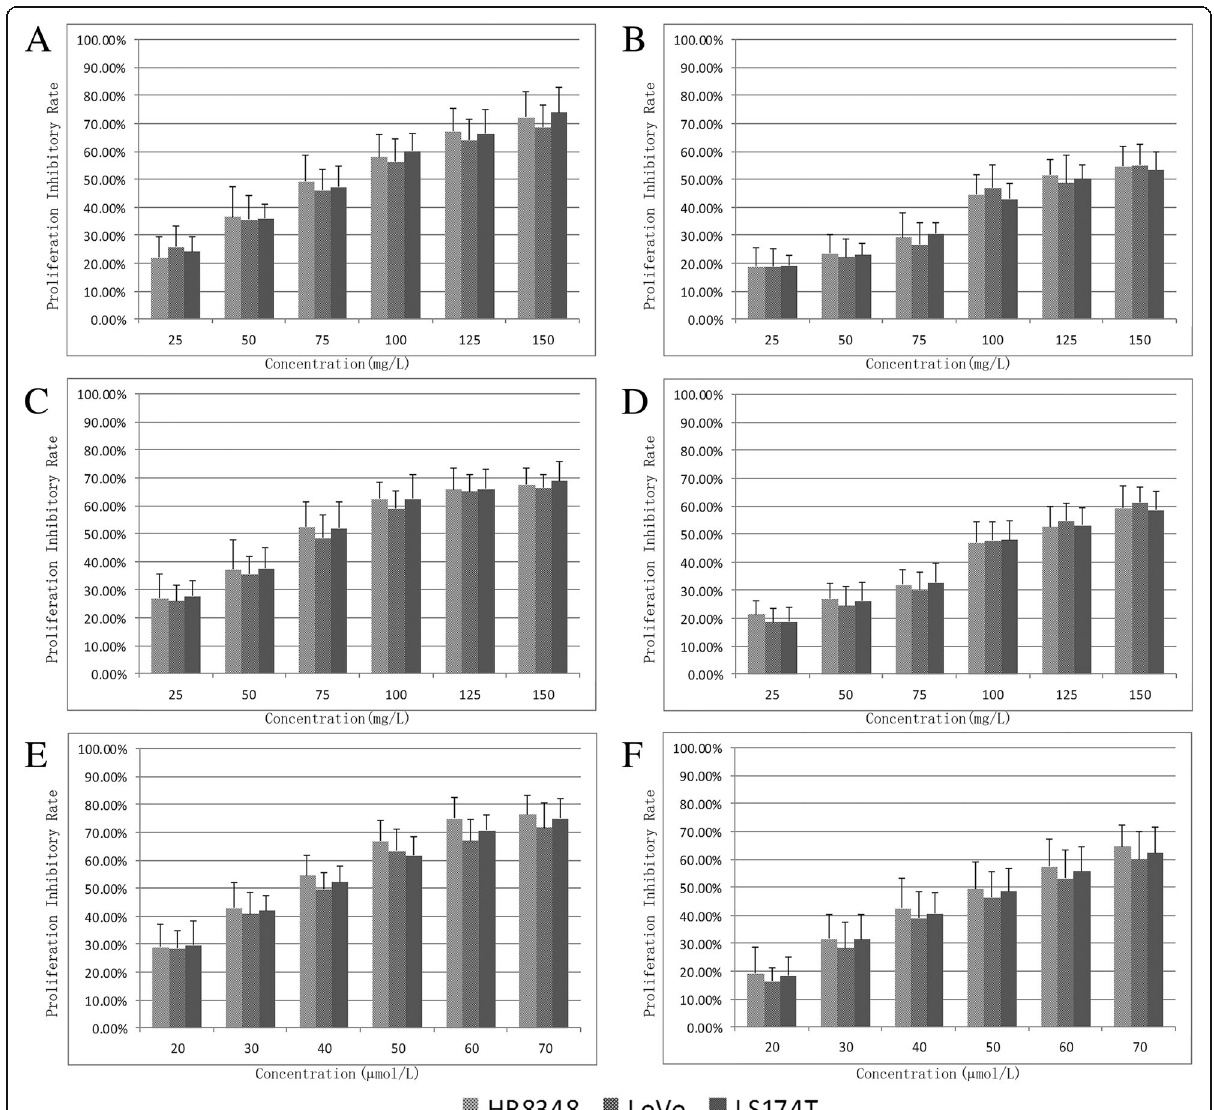
Fig. 2 Proliferation inhibition rates of different human colorectal carcinoma cells treated with a superior triphala (higher chebulinic acid, higher chebulagic acid); b inferior triphala (lower chebulinic acid, lower chebulagic acid); c inferior triphala with corrected chebulinic acid (higher chebulinic acid, lower chebulagic acid); and d inferior triphala with corrected chebulagic acid (lower chebulinic acid, higher chebulagic acid) or e chebulinic acid or f chebulagic acid at concentrations of 25, 50, 75, 100, 125, and 150mg/L for 48h. The relative IC 50 values were estimated with regression analysis by probit using SPSS and presented in Table